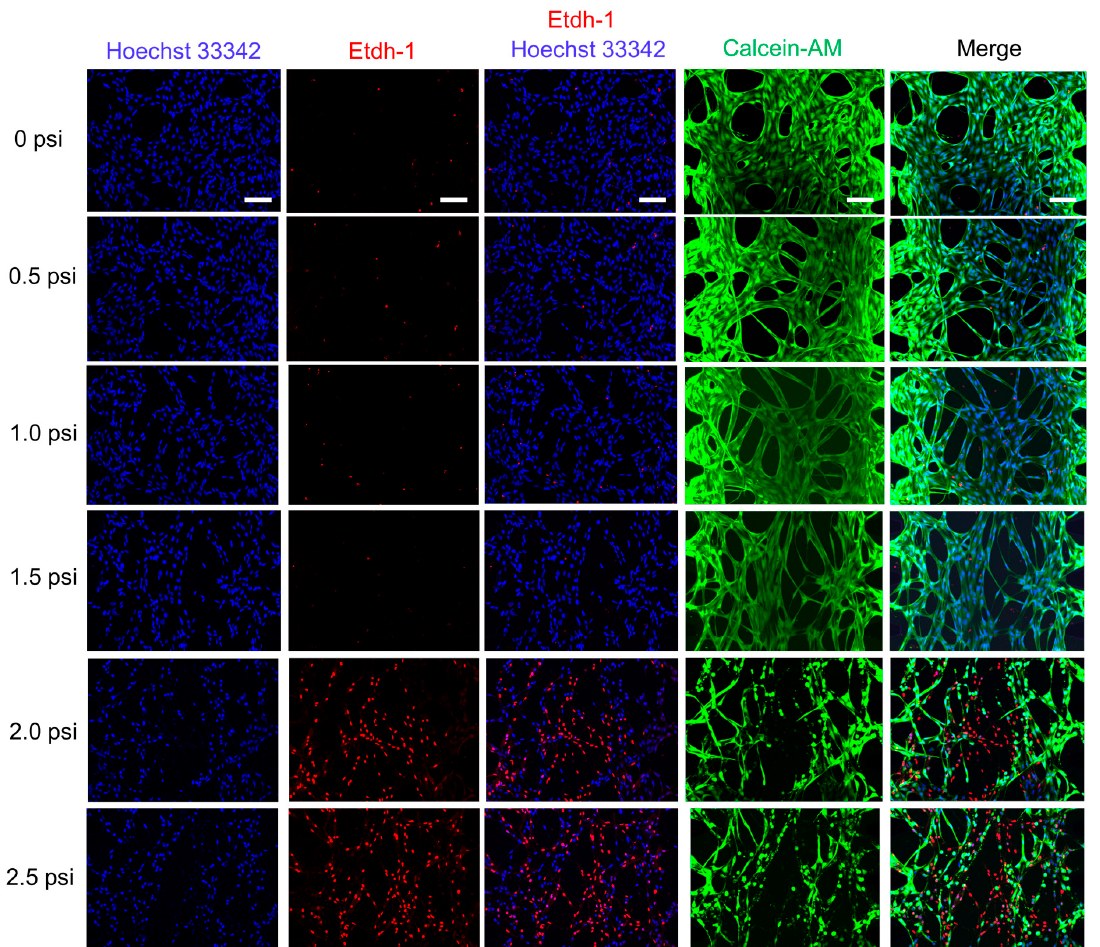
Figure 5. Microvascular network viability according to six different pressures. Cell viability was examined after a 1-min duration each at six different pressures and representative fluorescence images from each sample are shown. Scale bar: 80 μ m.